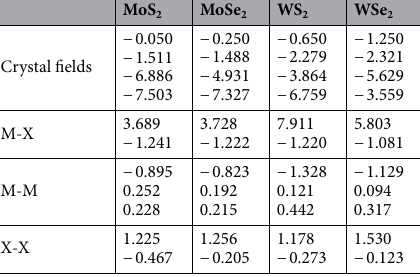
Table 1. Slater-Koster TB parameters for monolayer MoX 2 . Where M is Mo, W and X is S, Se. All terms are in units of eV and taken from Ref. 62